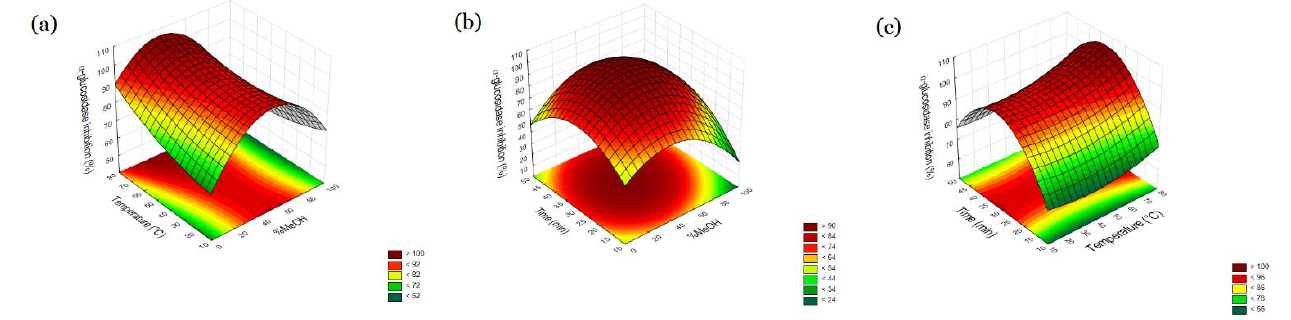
Figure 3. Response surface and contour plots percent of α -glucosidase inhibition as a function of methanol concentration (X 1) and temperature (X 2 ) ( a ), methanol concentration (X 1 ) and time (X 3 ) ( b ), temperature (X 2 ) and time (X 3 ) ( c ).